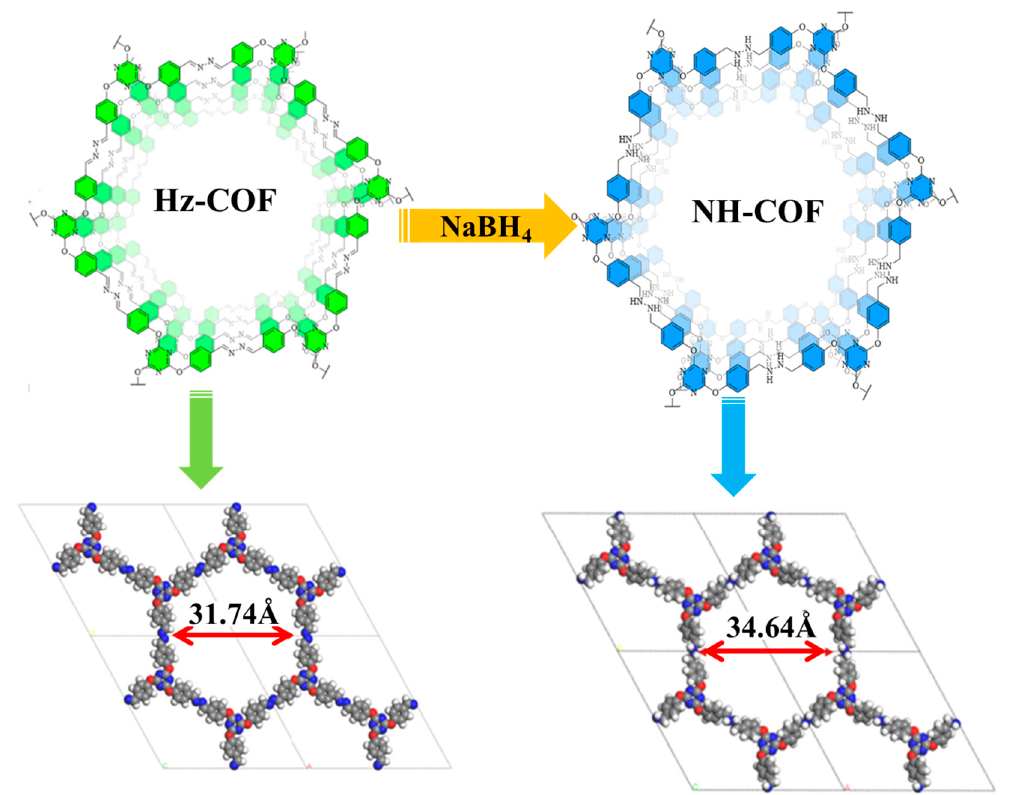
Figure 8. An illustration of Hz-COF and NH-COF, and their corresponding simulated views. Re- printed/adapted with permission from Ref. [65]. Copyright (2022), Elsevier.